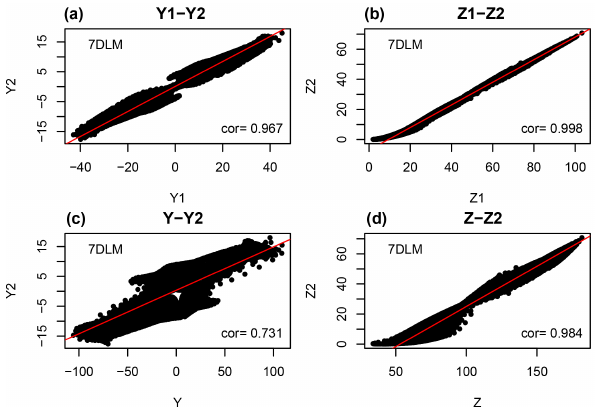
Figure 10. Scatter plots for the 7DLM with r = 120. The correlation coefficient for the secondary and tertiary modes (i.e., Y 1 and Y 2 or Z 1 and Z 2 in the top panels) is larger than that of the primary and secondary modes (i.e., Y and Y 1 or Z and Z 1 in the bottom panels of Fig. 9).